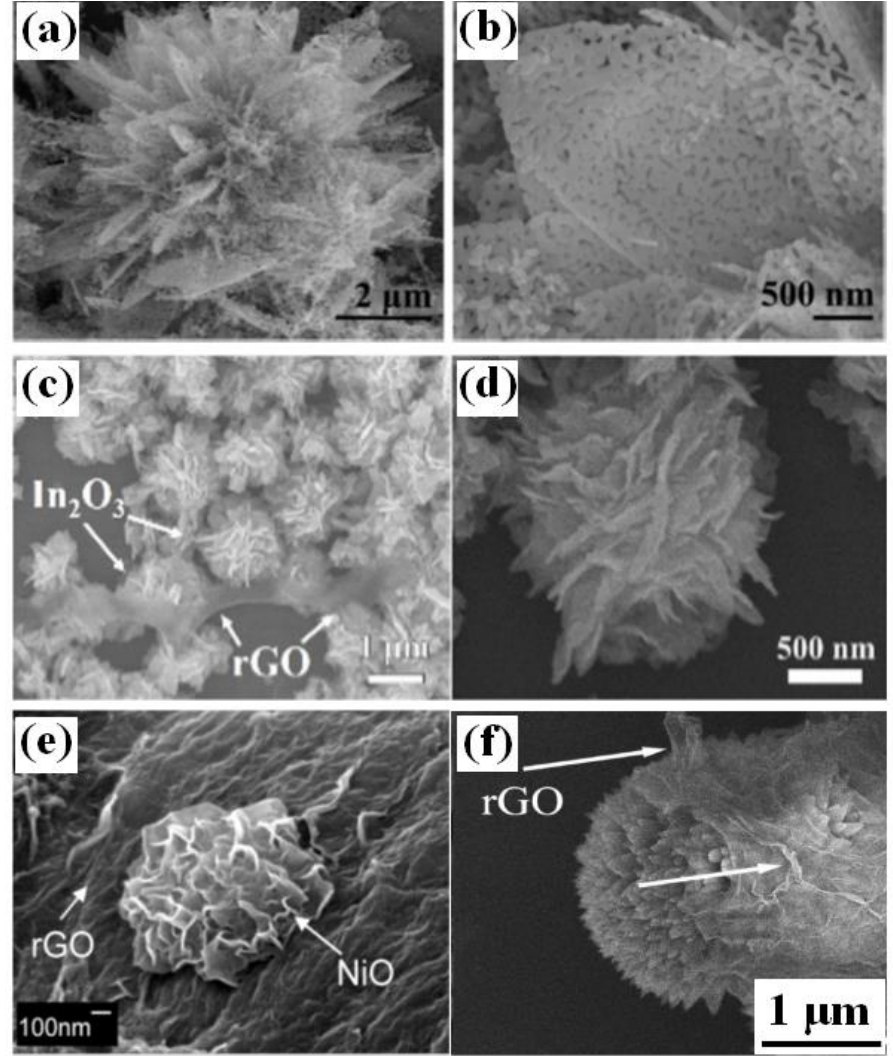
Figure 7. Morphology of ( a,b ) 3D hierarchical porous ZnO nanoflowers modified with rGO [83]; ( c,d ) 3D rGO-In 2 O 3 composite [84]; ( e ) rGO/NiO nanoflowers [85]; ( f ) urchinlike CuO 3D structures modified by rGO [86]. ( a–e ) were reproduced with permission from [83–85], © Elsevier. ( f ) were reproduced with permission from [86] © 2014 American Chemical Society